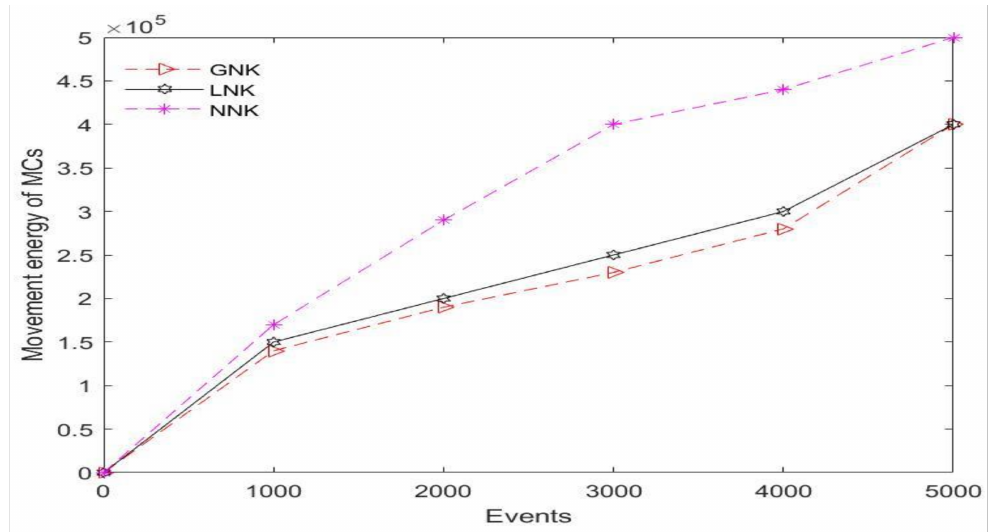
Figure 10. Movement energy of MCs over time.